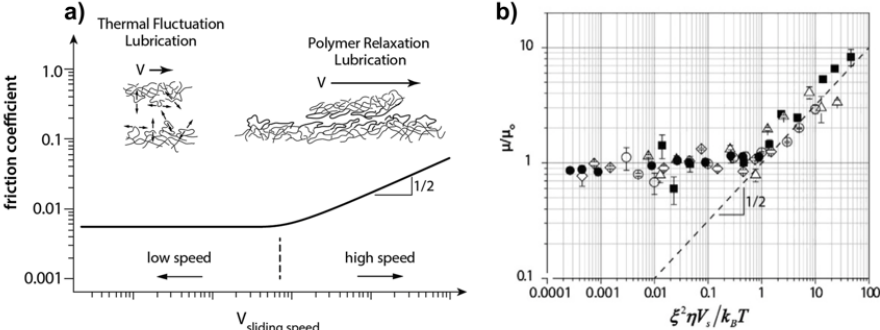
Figure 7. Gemini hydrogel lubrication model. ( a ) At low speeds, thermal fluctuation lubrication dominates, and the coefficient of friction is velocity-independent and small. At high speeds, polymer relaxation and adhesion are the dominant mechanism and the friction coefficient is higher and increases as V 0.5 . Reproduced from Ref. [31] with permission from The Royal Society of Chemistry.